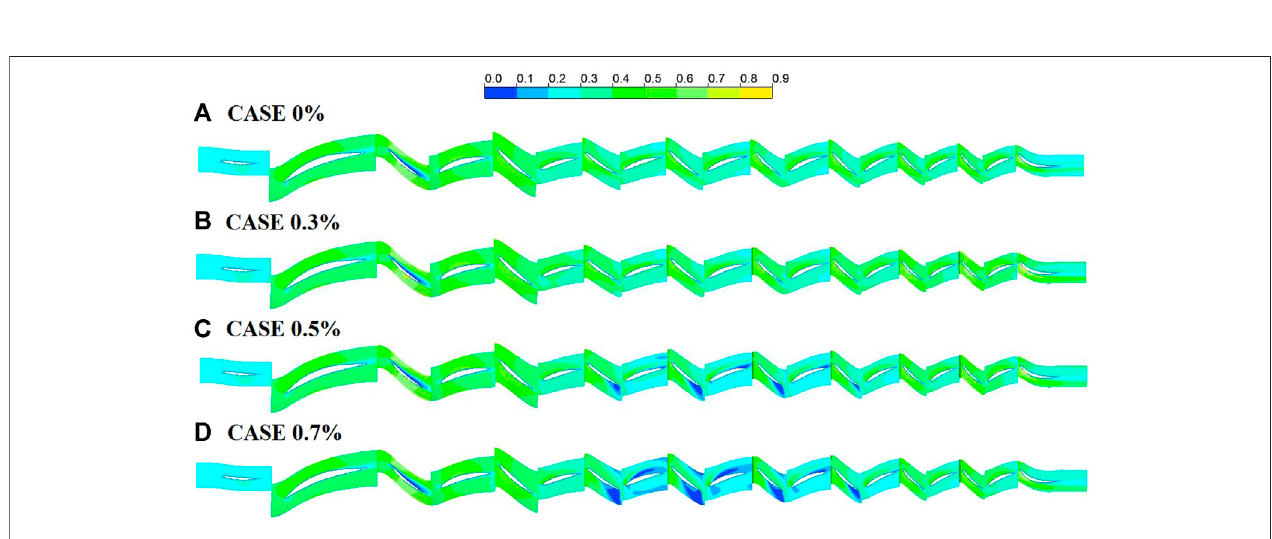
FIGURE 12 | Relative Mach number contours of 10% span at the nearest stall point of 75%n. CASE 0% (A) , CASE 0.3% (B) , CASE 0.5% (C) , CASE 0.7% (D)